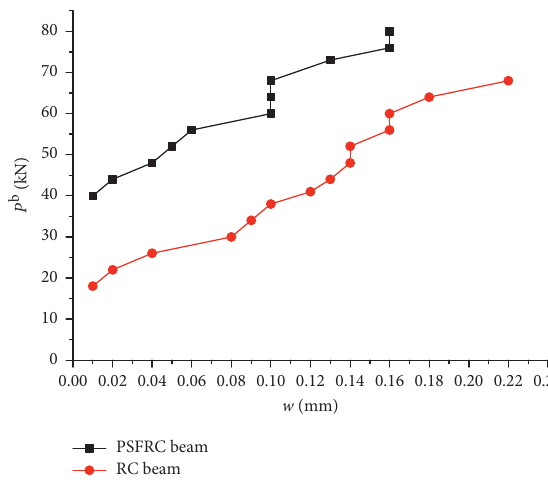
Figure 14: Plot of the main crack width versus